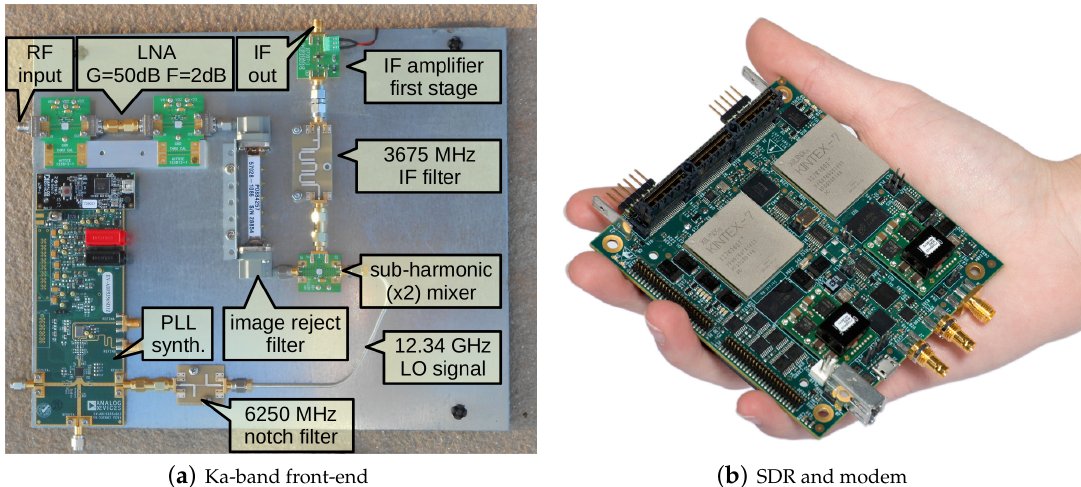
Figure 6. Prototypes. ( a ) Ka-band front-end breadboard operating from 27.5 to 30 GHz, ( b ) SDR and custom FPGA define both-based modem board. The 3.7 GHz IF signal is obtained by a sub-harmonically pumped mixer. The half-frequency LO is in the range between 11.90 to 13.15 GHz and it is generated by a PLL